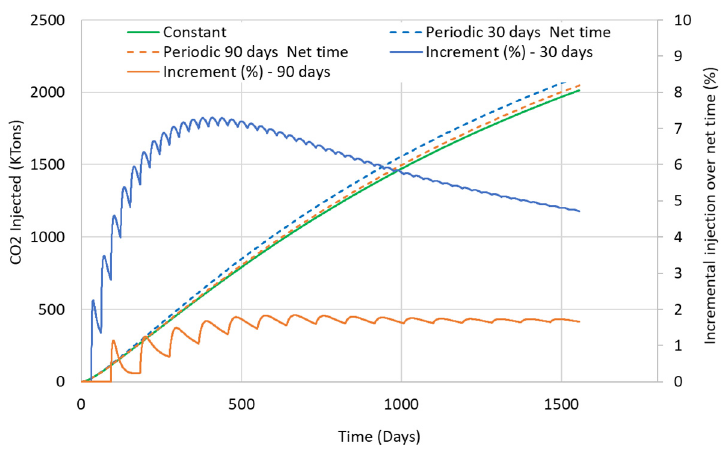
Figure 18. Mid-reservoir injection, comparing one-month vs. three-month cycles. Benefit of cycling appear much lower for this injector position. Longer cycles further reduce the benefit of periodic injection.